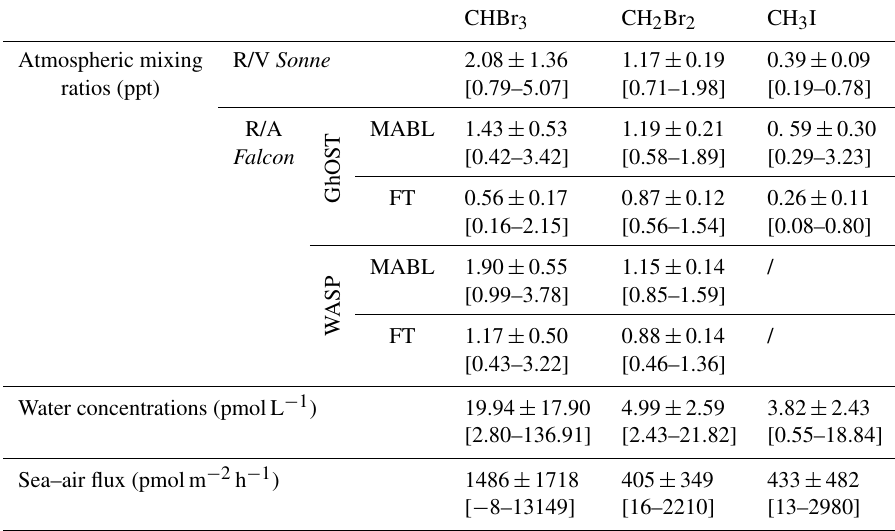
Table 1. Mean ± standard deviation and range of atmospheric mixing ratios observed on R/V Sonne (195 data points) and R/A Falcon (GhOST–MS with 513 and WASP GC/MS with 202 data points) in the MABL and the FT, water concentrations observed on R/V Sonne and the computed sea–air fluxes. MABL and FT mixing ratios on R/A Falcon are adopted from Sala et al. (2014) and Tegtmeier et al. (2013). The R/A Falcon MABL height was analysed to be 450m (Sala et al.,